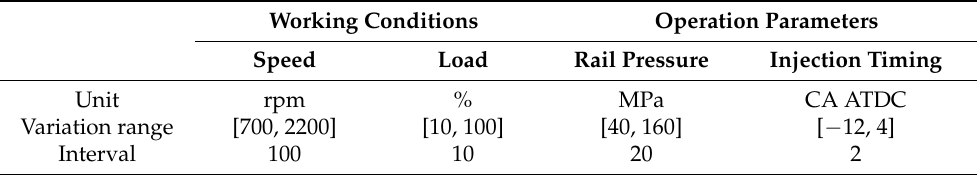
Table 2. Variation range of engine test conditions and operating parameters.